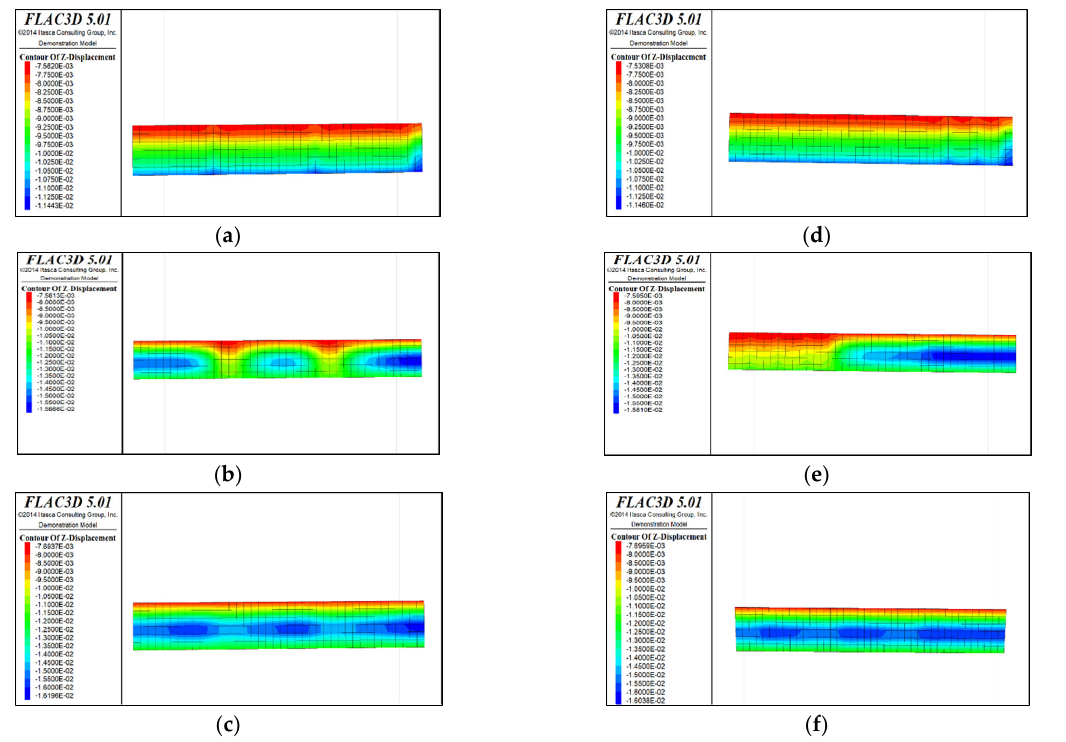
Figure 4. Z-direction displacement cloud pictures (plan views) for different periods under Schemes A and B with a roof protection layer thickness of 0.5 m. ( a ) After extraction and backfill of Drifts 1, 8, and 15 (Step 2). ( b ) After extraction of Drifts 6, 13, and 20 (Step 11). ( c ) After extraction and backfilling of Drifts 7 and 14 (last step). ( d ) After extraction and backfill of Drifts 1, 3, and 5 (Step 2). ( e ) After extraction of Drifts 8, 10, and 12 (Step 11). ( f ) After extraction and backfilling of Drift 20 (last step).